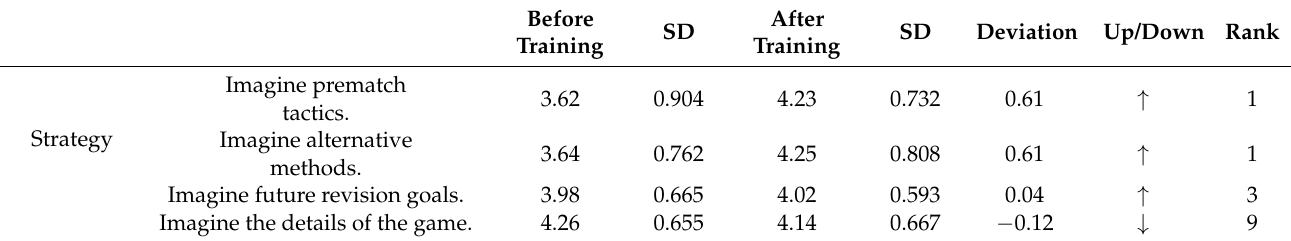
Table 4. Perception analysis of the effect of imagery training on imagery ability. Before